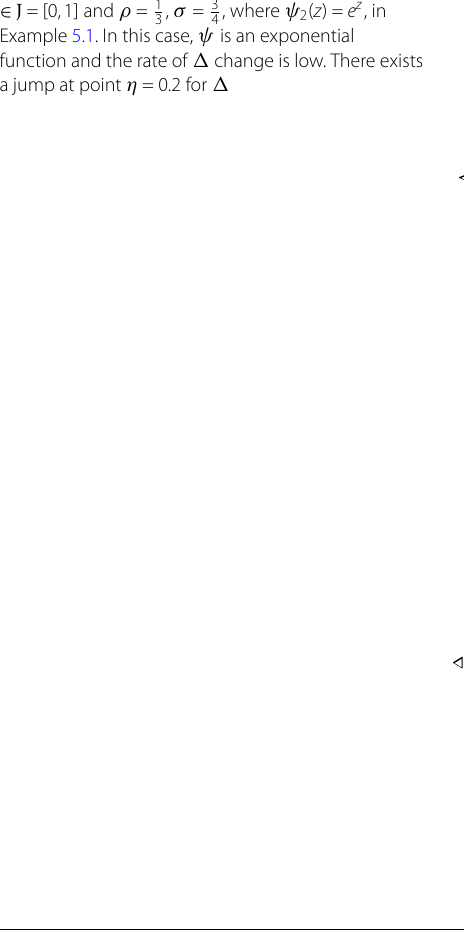
Figure 2 Graphical representation of (cid:25) and (cid:27) for η ∈ J = [0,1] and ρ = 1 , σ = 3 , where ψ 2 ( z ) = e z , in 3 4 Example 5.1. In this case, ψ is an